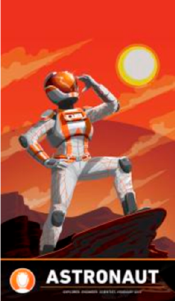
Figure 25. Image target (used dimensions: 512 × 885).